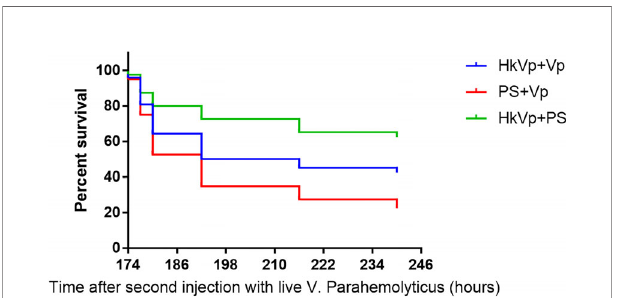
FIGURE 2 | Cumulative survival using the Kaplan-Meier method following the ICP with live V. parahaemolyticus after previous IPP with heat-killed V. parahaemolyticus (HkVp group) or physiologic (0.9%) saline (PS group) in S. paramamosain . “ 168 – 240 h ” denotes the time started after the ICP. This survival experiment was repeated three times.